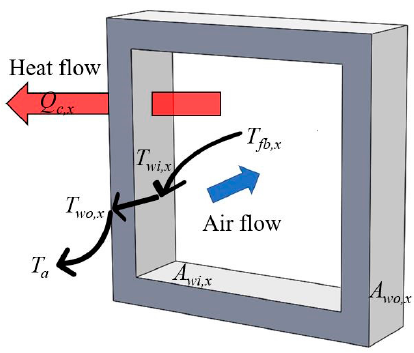
Figure 4. Schematic of pipe heat transfer.